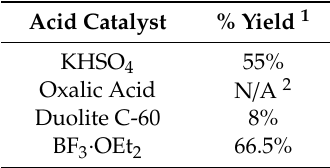
Table 1. Yields for di ff erent acid catalysts used in the synthesis of vitamin K 1 [54].